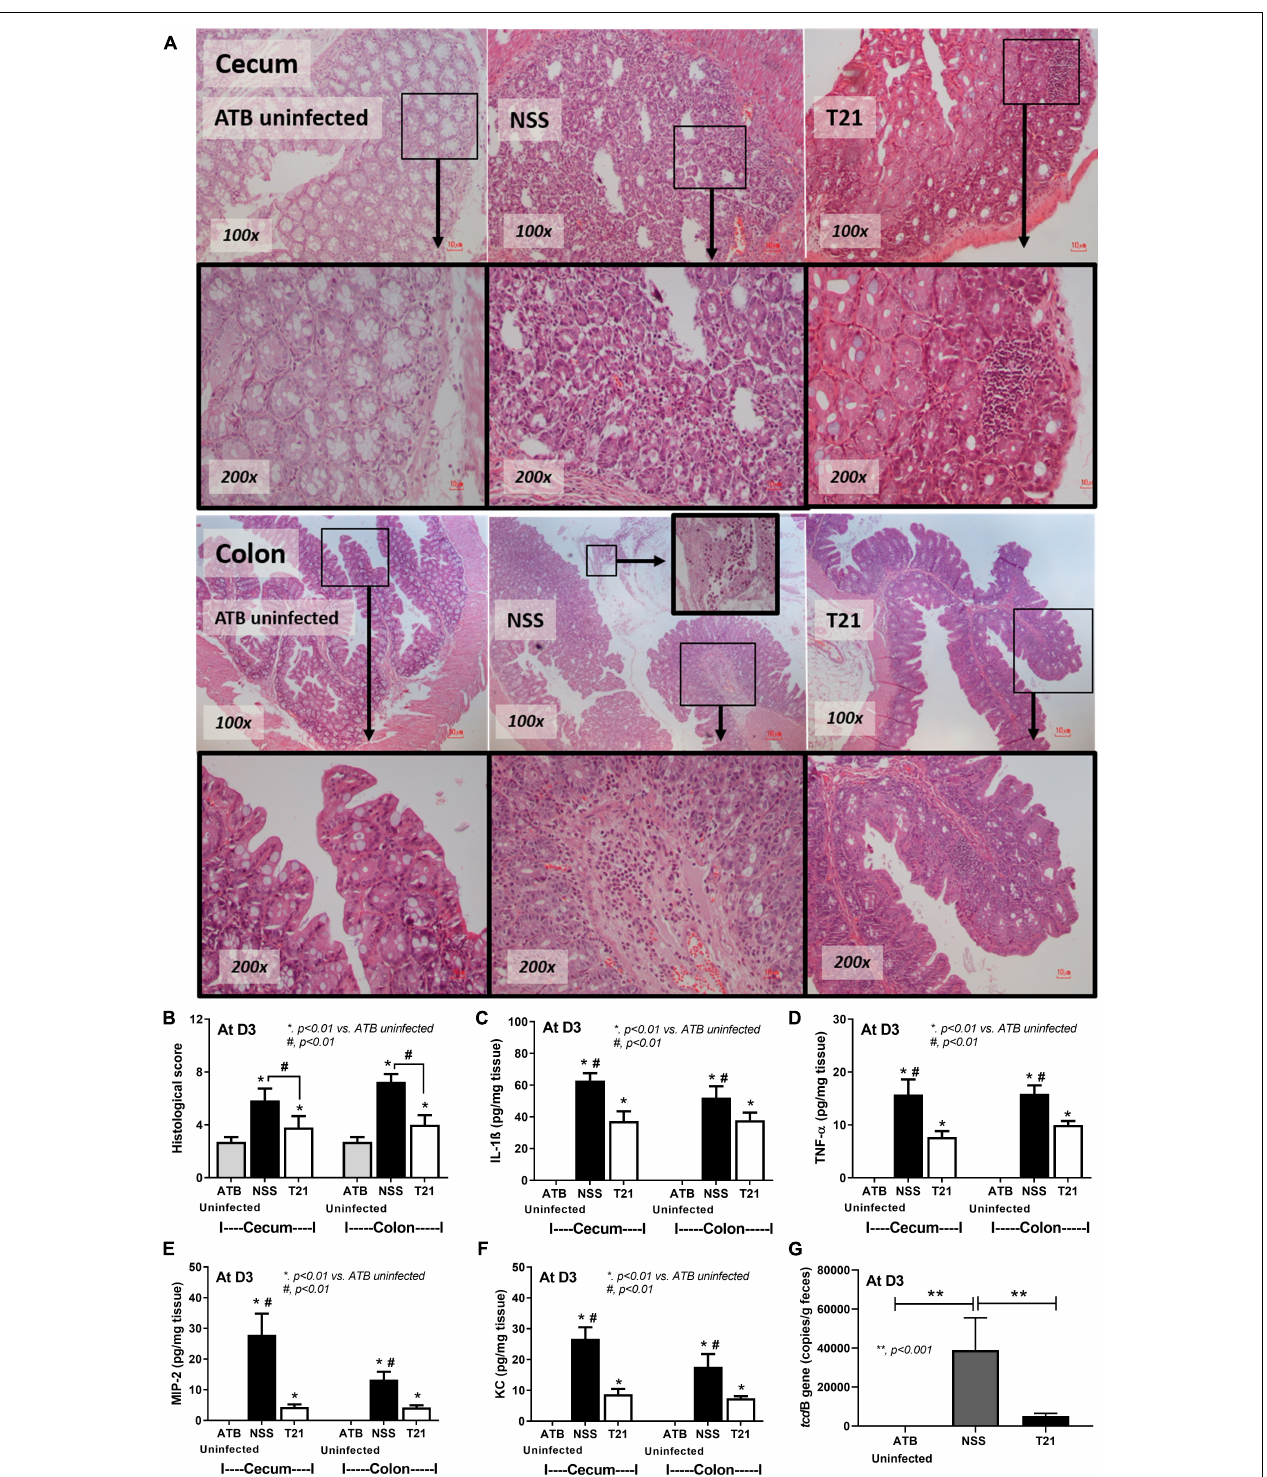
FIGURE 3 | Lacticaseibacillus casei T21 attenuated C. difficile -induced cecal and colonic tissue damage. Three groups of mice ( n = 8 for each group) as described in Figure 2 were sacrificed at day 3 and examined for histopathology and local inflammation. Representative image of hematoxylin and eosin (H&E) staining sections (A) , histological scores (B) , and levels of intestinal pro-inflammatory cytokines (C–F) are shown. The copy number of tcdB , which represents C. difficile abundance in each group of mice, is demonstrated (G) . *p < 0.01; **p < 0.001 ; # p < 0.01.